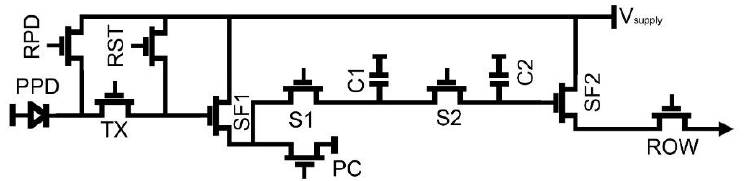
Figure 3. Pixel circuit schematic of designed novel 9T GSI pixel.